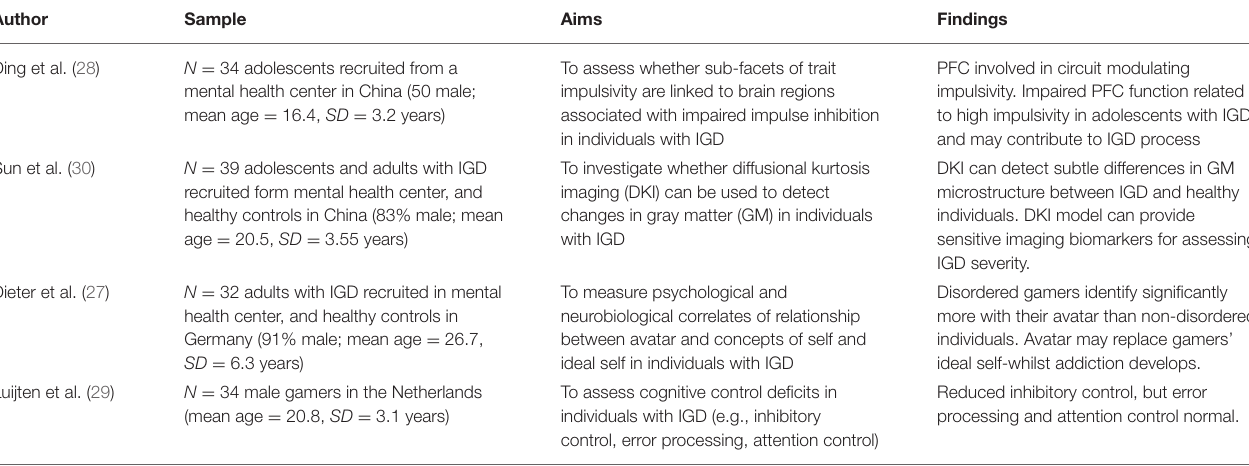
TABLE 1 | Functional magnetic resonance imaging (fMRI) studies of Internet Gaming Disorder